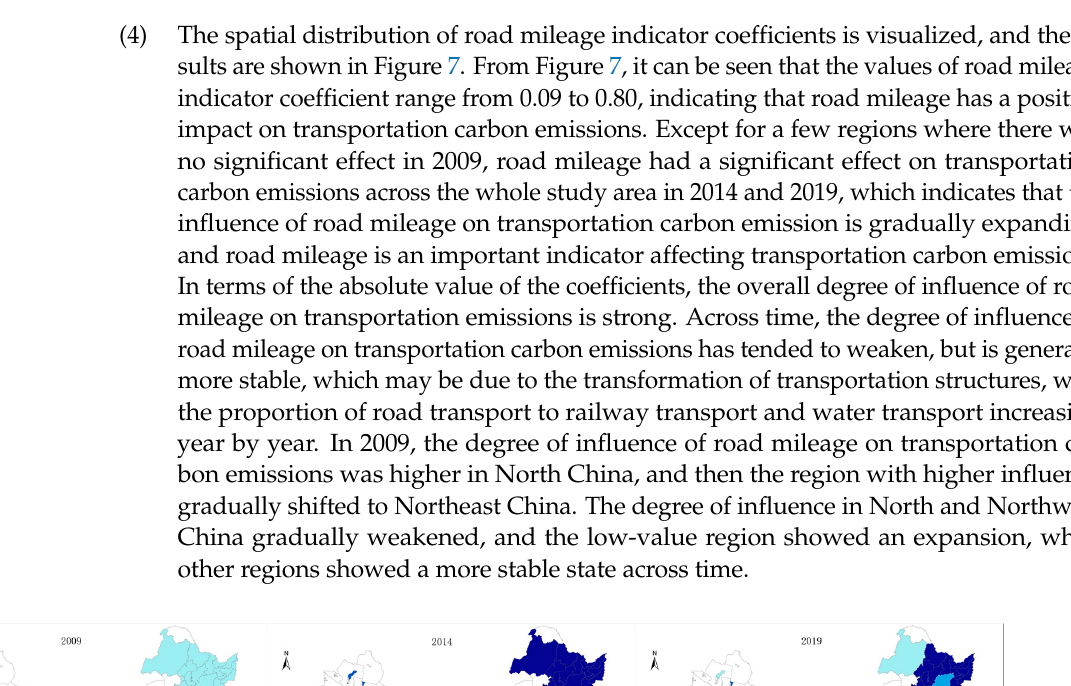
Figure 6. Spatial distribution of GDP per capita indicator coefficient.